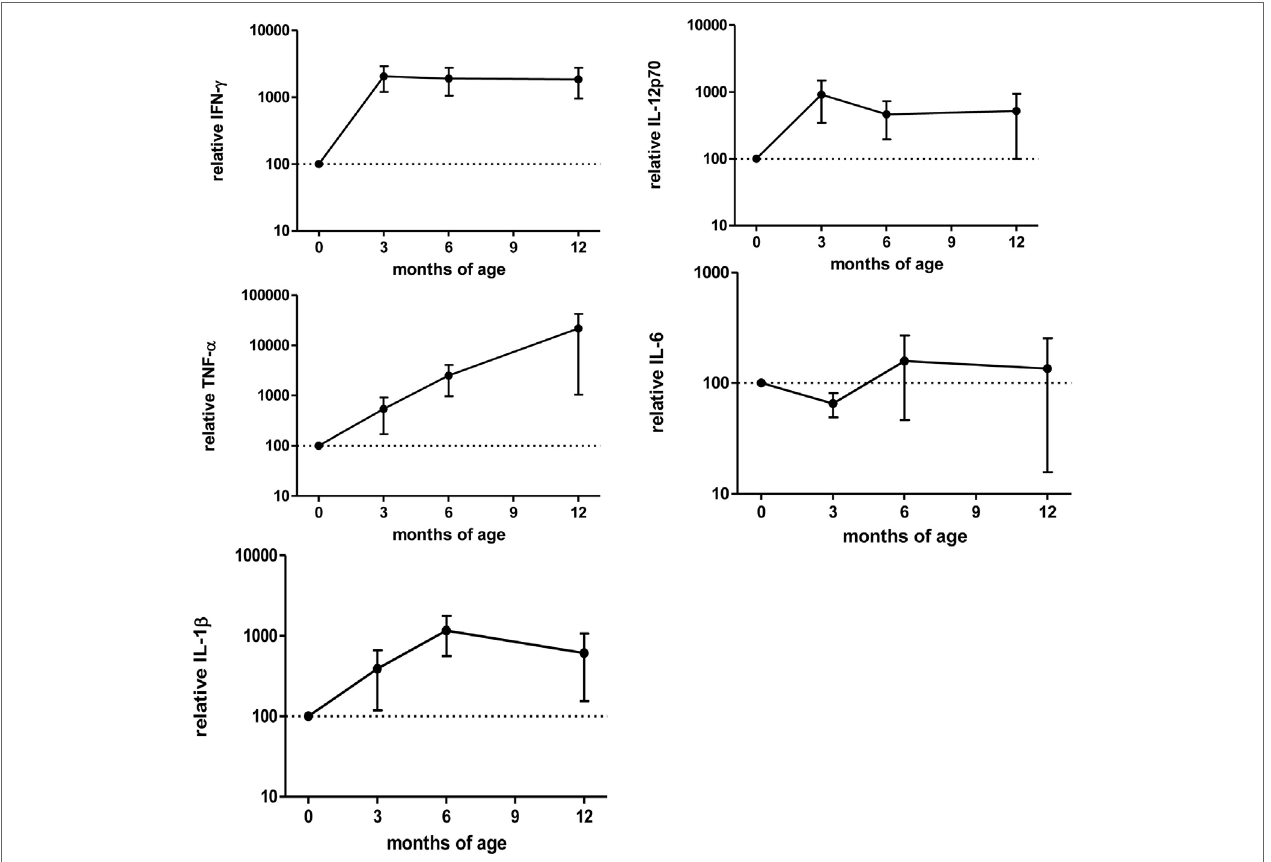
FigUre 6 | Cytokine secretion in the first months of age related to birth in exposed infants. Cytokine secretion measured by Luminex after 48 h culture with Bacillus Calmette–Guérin. Values are relative to “birth” (0) time point. Points represent mean and bars SE of the mean. Adalimumab-exposed infants, n = 3; infliximab-exposed infants, n = 1